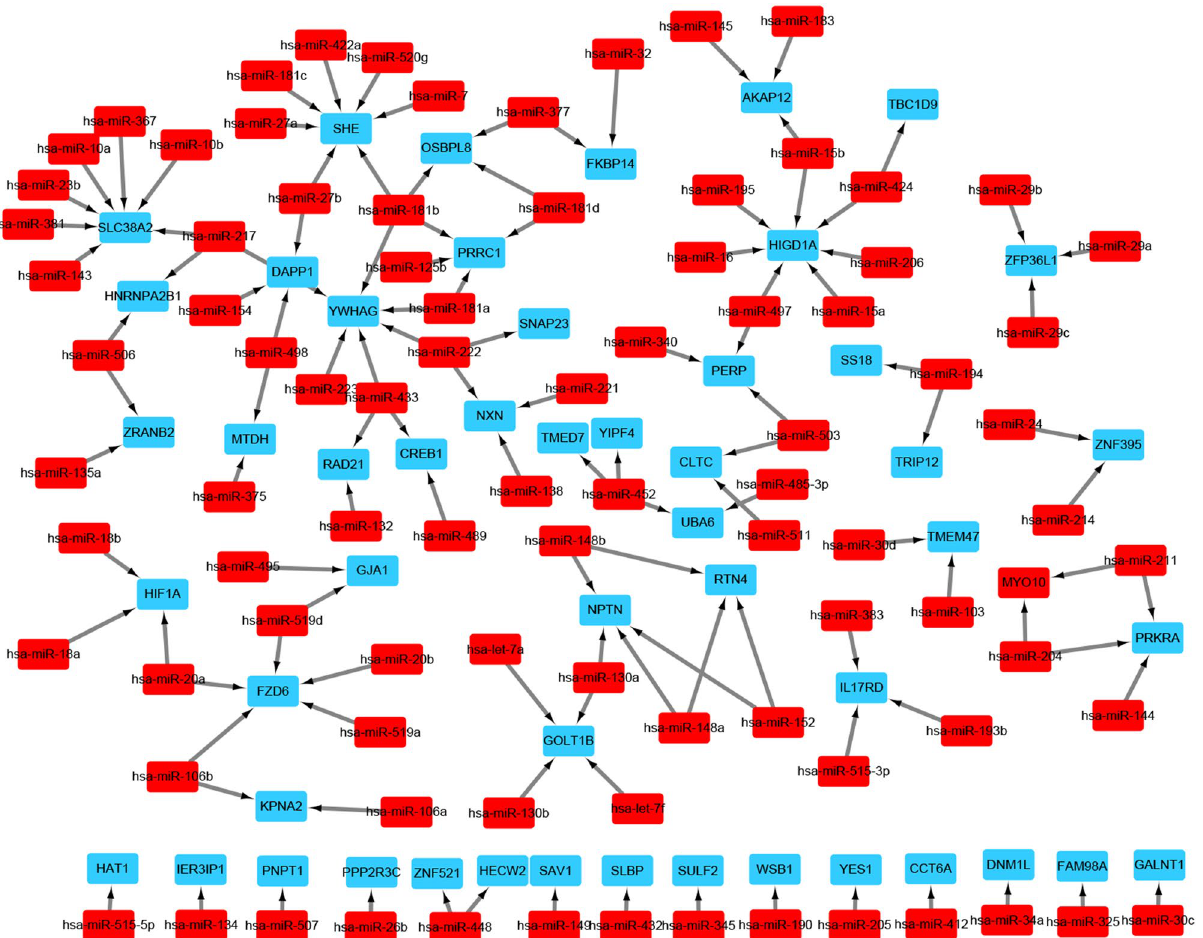
cytoscape software 3.6.1 (www. cytos cape.